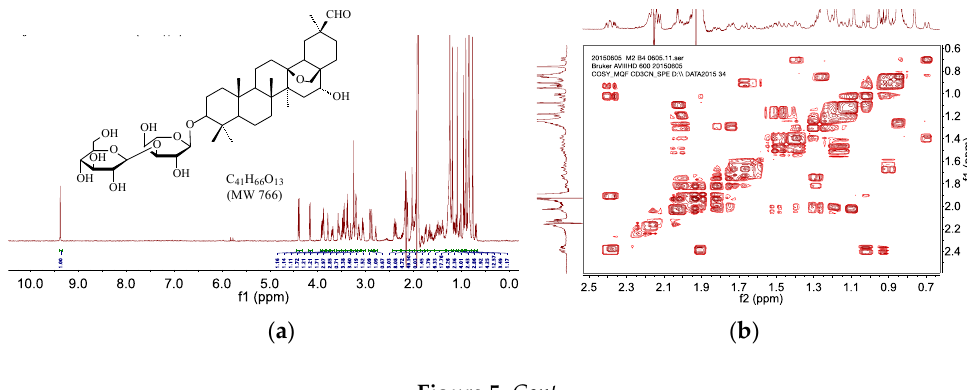
Figure 5. Cont. Figure 5. Cont.